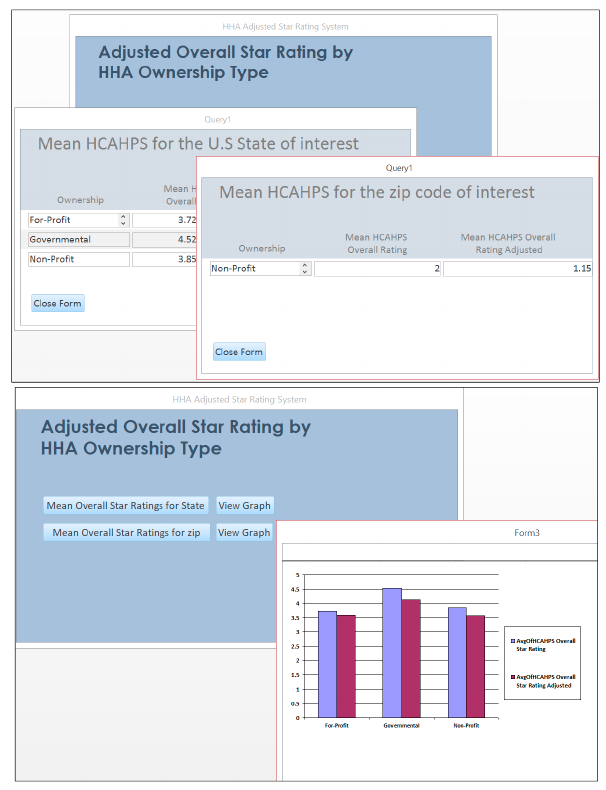
Figure 3. Prototype application for the comparison of HCAHPS summary star ratings. Top: The user selected a US state to review mean, adjusted HCAHPS ratings, and ratings for the zip code of interest. Bottom: Bar charts comparing adjusted and non-adjusted star ratings for each proprietary organization type.